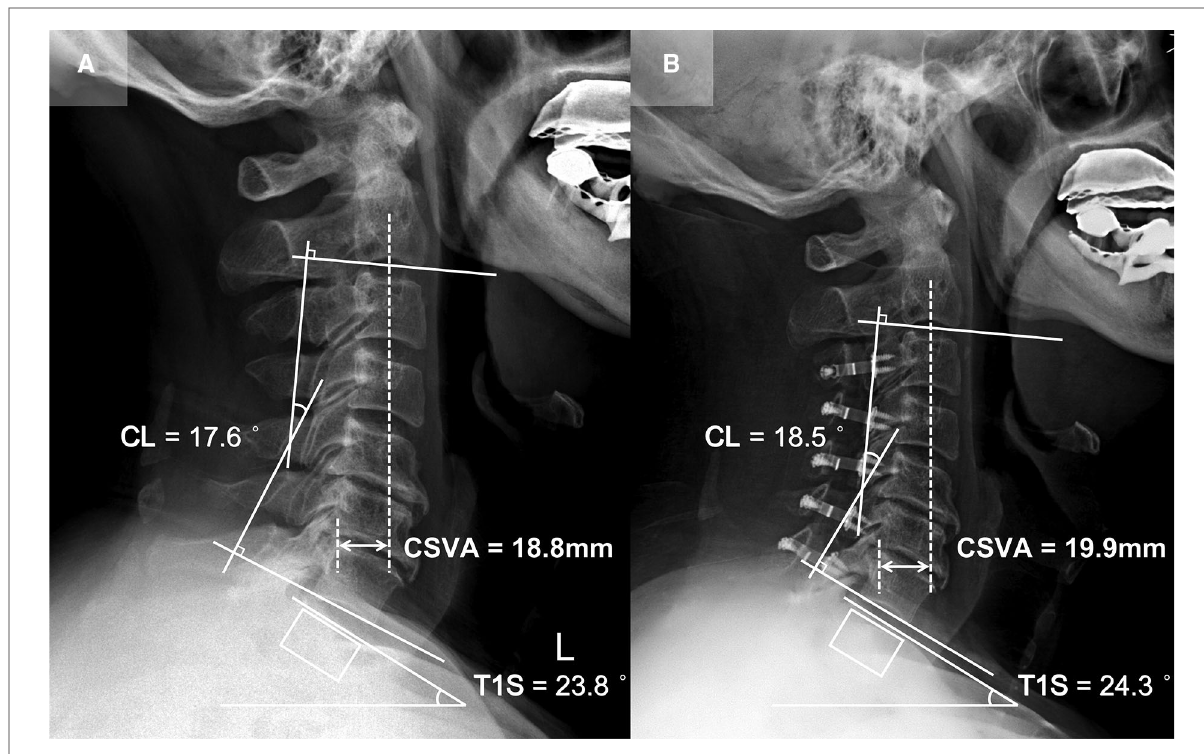
score and NDI were 12 and 12%, respectively. CL and T1S were 18.5° and 24.3° at fi nal follow-up, respectively. The change of CSVA was +1.1 mm. JOA score increased from 12 to 16, while NDI decreased from 12% to 6%. The JOA recovery rate was 80%. Patient 2 (CL loss group, T1S decreased subgroup; Figure 4 ): A 65-year-old male with a 15-month follow- up. The preoperative CL was 7.1°, the preoperative T1S was 26.5°. Preoperative JOA score and NDI were 12 and 10%, respectively. CL and T1S were 2.3° and 21.4° at fi nal follow-up, respectively. The change of CSVA was − 2 mm. JOA score increased from 12 to 15, while NDI decreased from 10% to 6%. The JOA recovery rate was 60%. Patient 3 (CL loss group, T1S sustained subgroup; Figure 5 ): A 56-year-old female with a 14-month follow- up. The preoperative CL was 18.8°, the preoperative T1S was 23.1°. Preoperative JOA score and NDI were 11 and 30%, respectively. CL and T1S were 10.5° and 23.3° at fi nal follow-up, respectively. The change of CSVA was +5.7 mm. JOA score increased from 11 to 14, while NDI decreased from 30% to 14%. The JOA recovery rate was